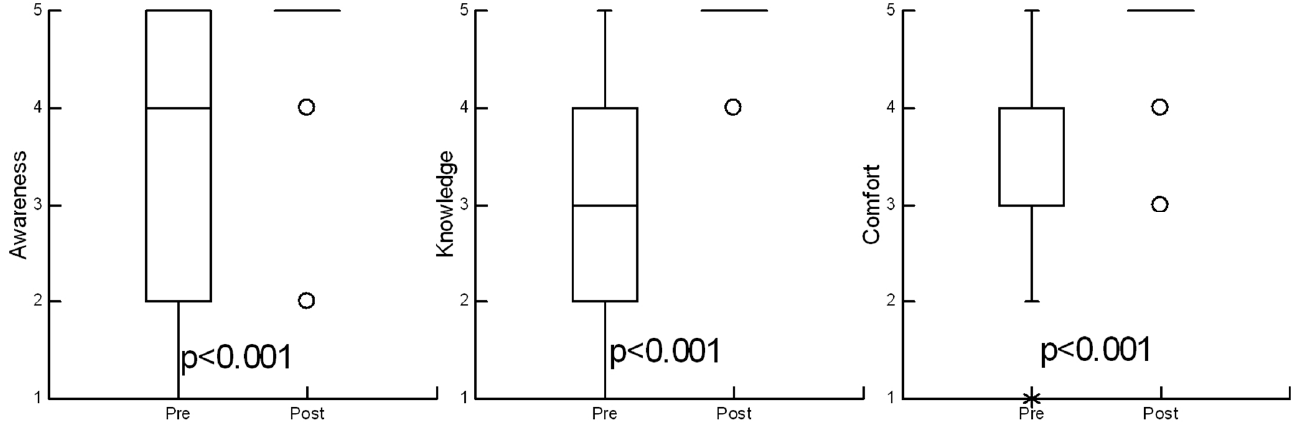
Figure 3. Median score pre and post-choking education. Boxes are median and 25–75th percentiles. Whiskers represent upper and lower fences 1.5× interquartile range. * points inside outer fences 3× interquartile range. Open circles are extreme outliers.